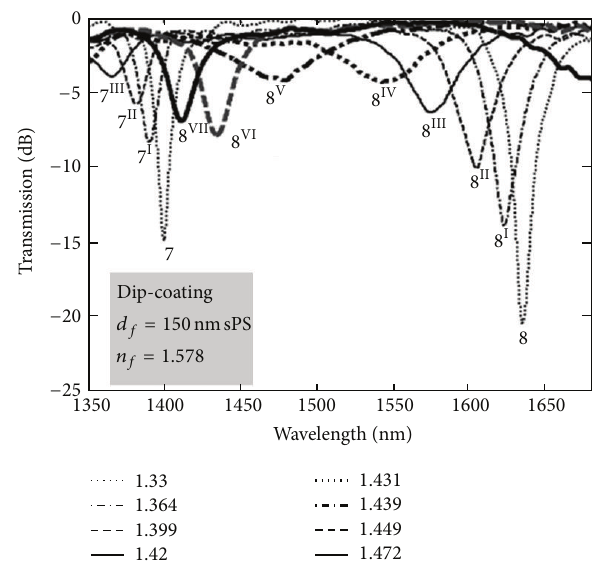
Figure 14: Resonances in the transition region of a dip-coated film (Taken from [47]).